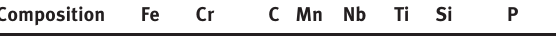
Table 1: The chemical compositions of the stainless steel 441. Composition